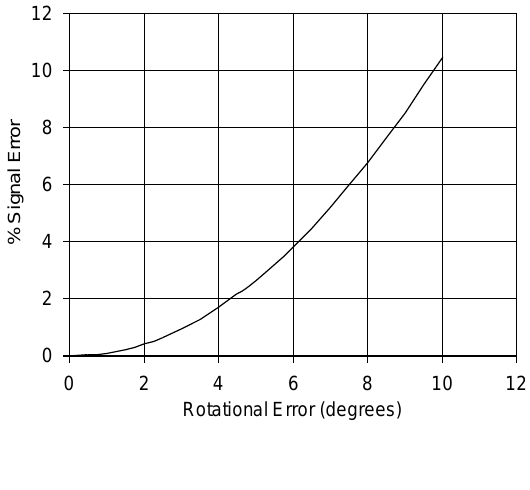
Figure 28. FEA results showing the effect of alignment/rotational error on the sensor output signal. The rotational error is measured from [110] direction, number of FEA runs =